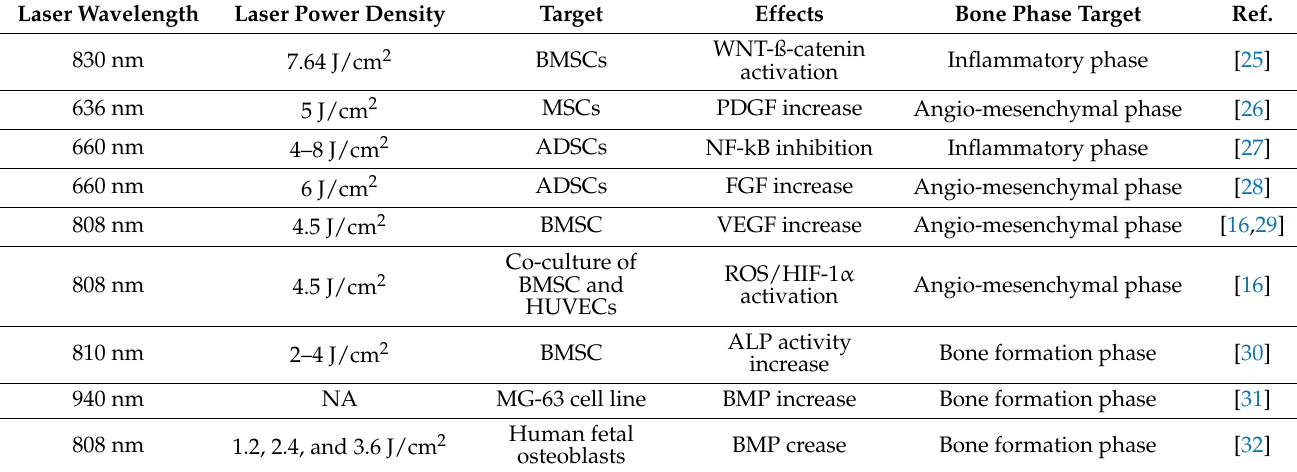
Figure 2. Schematic representation of molecular pathways activated by Low-Level Laser Therapy (LLLT). Abbreviations: VEGF (vascular endothelial growth factor); FGF (Fibroblast Growth Factors); PDGF (Platelet-Derived Growth Factor); TGF-ß (tumor growth factor- ß); BMPs (bone morphogenetic proteins); AKT (AKT Serine/Threonine Kinase 1); PI3K(Phosphatidylinositol-4,5-Bisphosphate 3-Kinase Catalytic Subunit Delta); MAPK (mitogen-activated protein kinase); ERK (extracellular signal-regulated kinase 1/2); SMAD proteins (small mothers against decapentaplegic); runx -2 (runt-related transcription factor gene); col1 (collagen type 1 gene); ocn (osteocalcin gene); opn (ostepontin gene); ibsp (bone sialoprotein gene). Table 2. Summary of in vitro LLLT